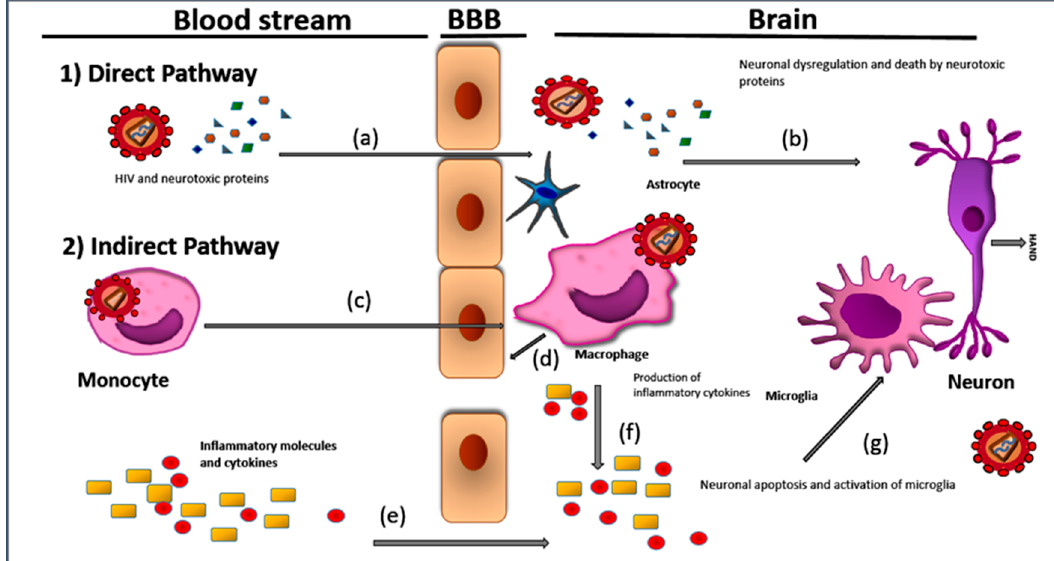
Figure 1. Mechanism of neuropathogenesis. Two pathways involved shown by arrows: (1) Direct pathway caused by HIV and released HIV proteins. (2) Indirect pathway involving secretion cytokines. ( a ) Virus particles and viral proteins shed and cross Blood brain barrier (BBB). ( b ) Neural injury caused by direct viral infection and dysregulation by viral proteins. ( c ) Infected monocyte infiltrating BBB. ( d ) Release of cytokines from infected monocytes contributing to disruption of BBB. ( e ) BBB become more permeable to cytokines present in the periphery. ( f ) More cytokines released into the brain and ( g ) cytokines disrupt normal functioning ultimately leading to neuronal apoptosis resulting in different forms of HIV associated neurocognitive disorders (HAND).